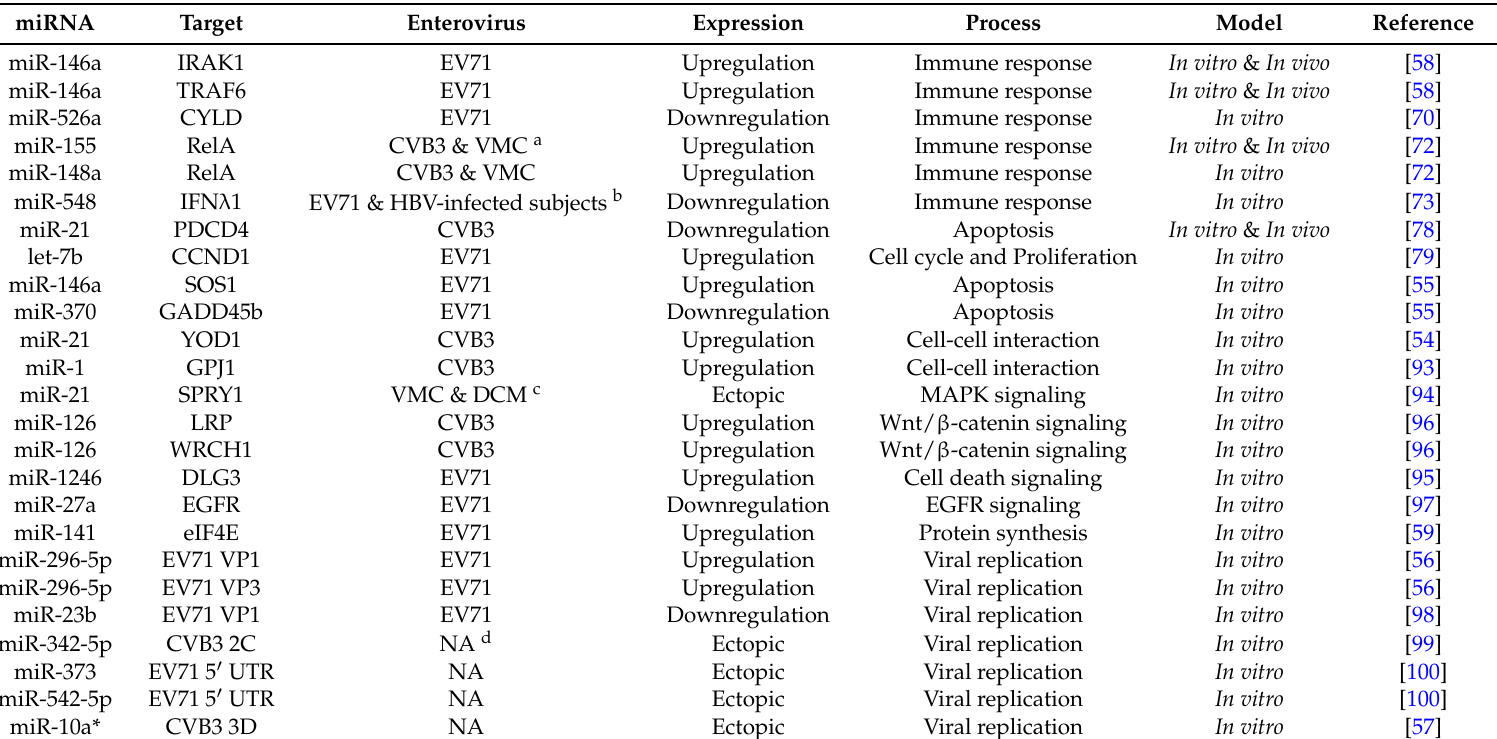
Table 1. MicroRNAs(miRNAs) regulations in Enteroviruses